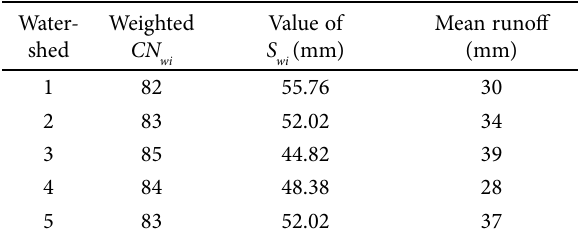
, S and monthly mean runoff for wi wi